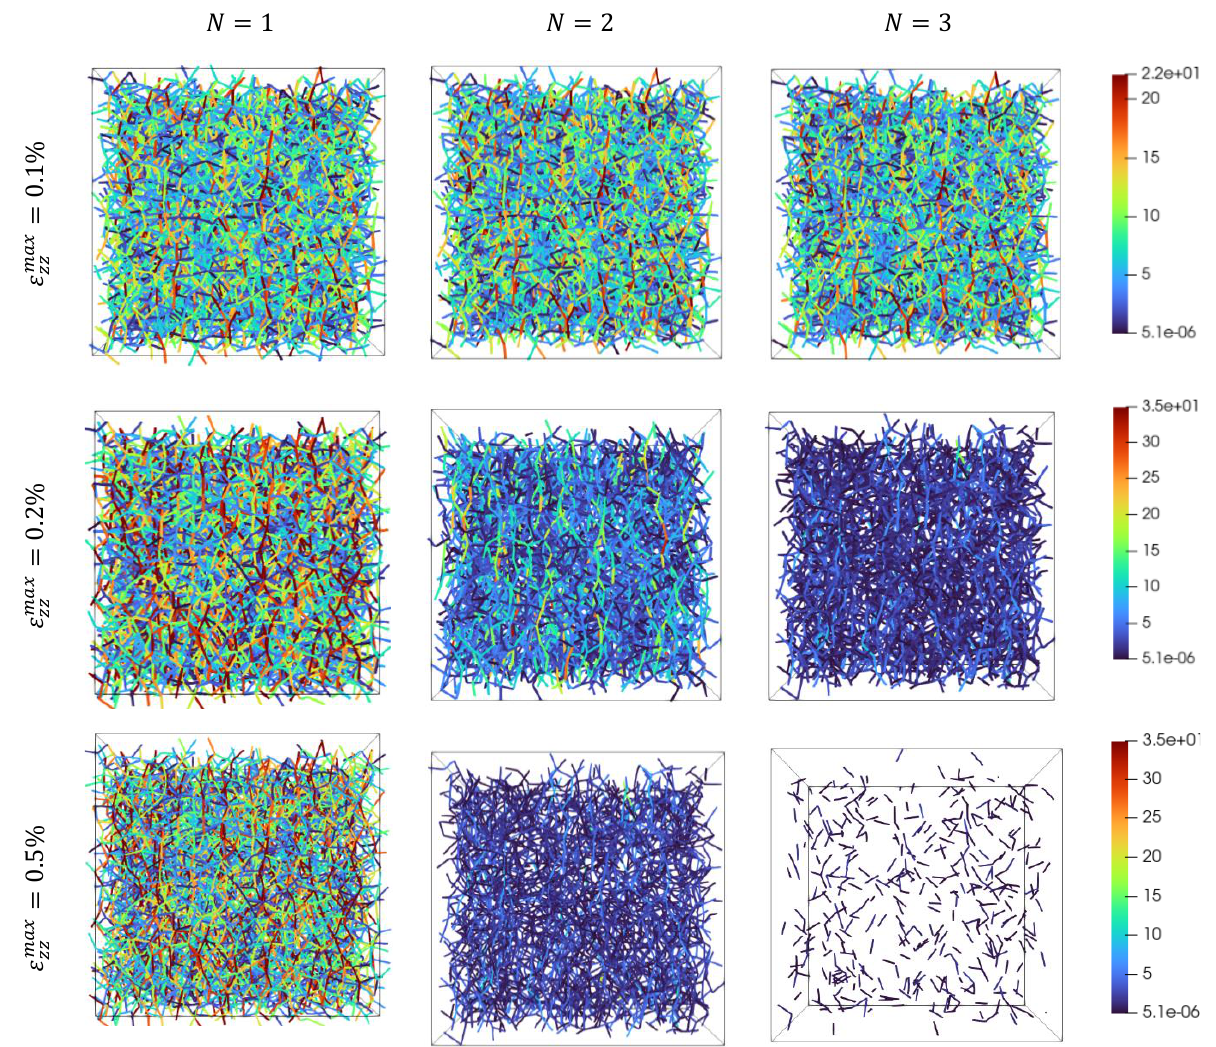
Figure 7. Normal contact forces for a representative volume element obtained from the results of the cyclic triaxial testing for loose sand at various maximum axial strain levels and at an increasing number of cycles (values in Newton).